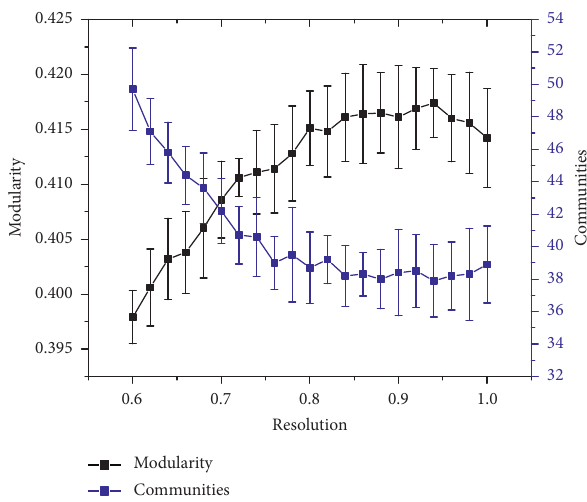
Figure 5: Dual-line plot with modularity (on left y -axis) and community number (on right y -axis) versus resolution. Table 6: Size, proportion, and cumulative proportion of com- munities (topics) in the complex network of traditional Chinese cultural